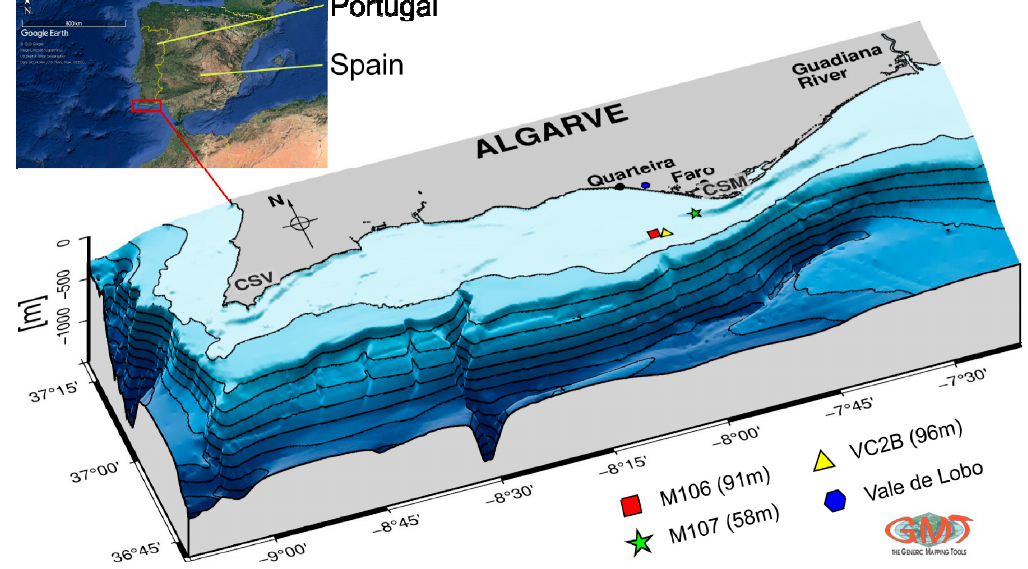
Figure 1. Bathymetry map of the study area in 3D-perspective and core locations. The contour lines are at 100 m intervals. Cores M106 (red, 91 m bsl) and M107 (green, 58 m bsl) were analyzed in the present study, while core VC2B (yellow, 96 m bsl) was analyzed for tsunami imprints by Quintela et al. [19]. CSV = Cape St. Vincent; CSM = Cape Santa Maria. The map was produced using GMT v6.0 [49].